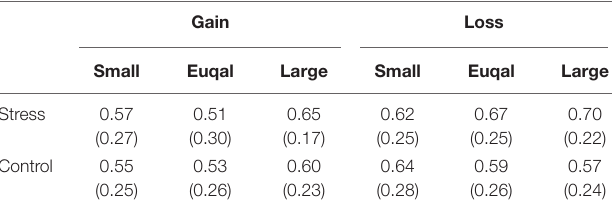
TABLE 3 | Means (Standard Error of Mean) in the conditional entropy showed relatively higher values ( H > 0.50) in all experimental conditions.